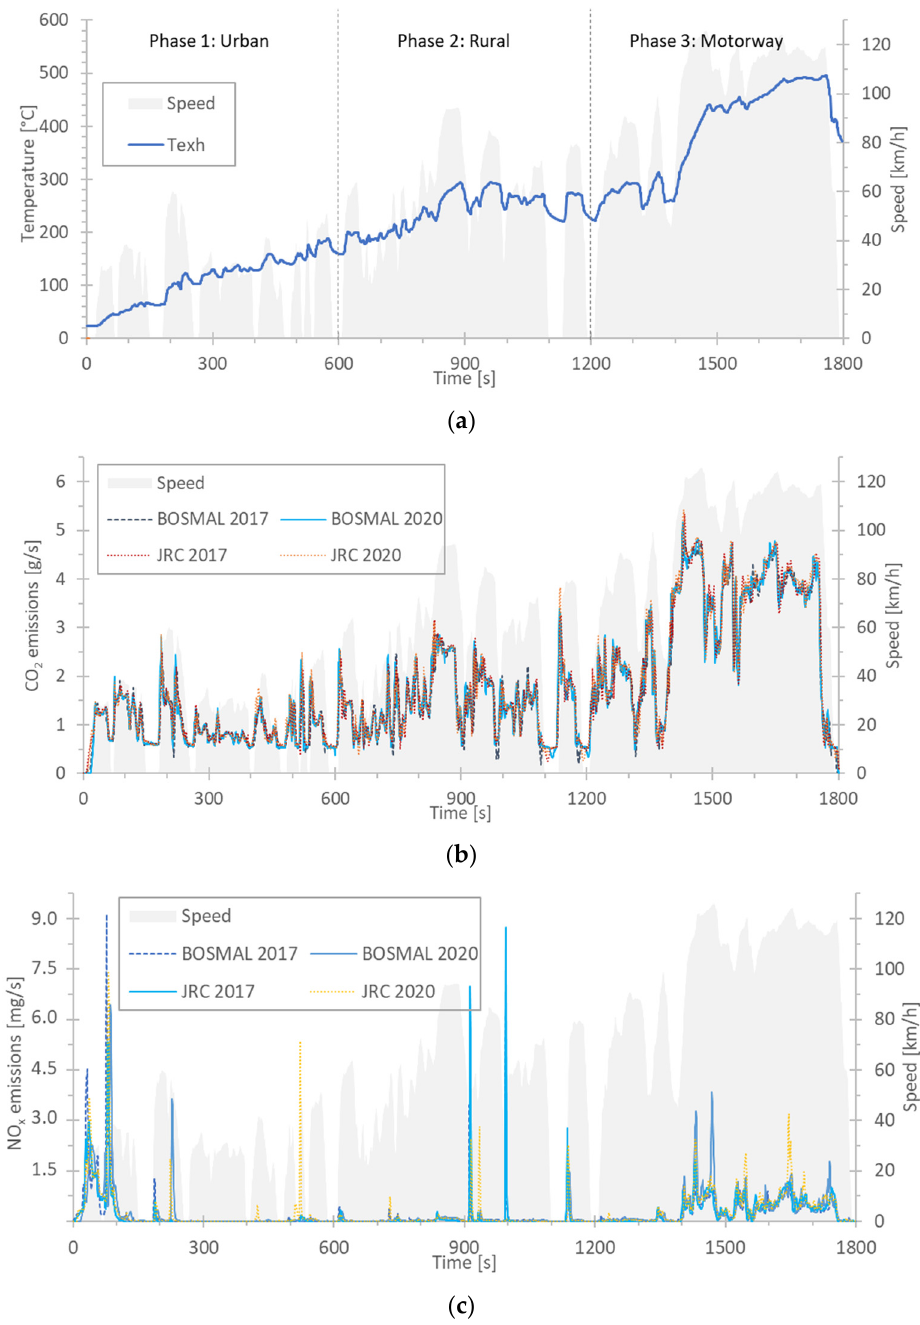
Figure A1. Examples of real time emissions at the four measurement campaigns: ( a ) Exhaust gas temperature; ( b ) CO 2 ; ( c ) NO x .